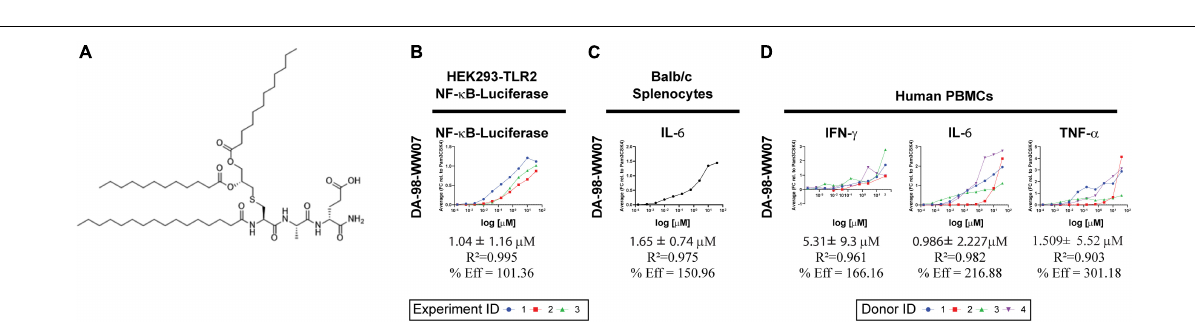
FIGURE 3 | Activity of a novel TLR1/2 agonist, DA-98-WW07. (A) Structure of DA-98-WW07 (IUPAC Name) (4 R ,7 S ,10 R ,14 R )-4-carbamoyl-14-(dodecanoyloxy)- 7-methyl-6,9,17-trioxo-10-palmitamido-16-oxa-12-thia-5,8-diazaoctacosanoic acid). (B) Luciferase expression in HEK293-cells stable transfected with FLAG-tagged human TLR2 and a NF- κ B-luciferase reporter gene after stimulation with various doses of DA-98-WW07. Pam 3 CSK 4 was used as a benchmark for the calculation of percent efficacy. The curves represent three independent experiments. The top curve was generated from only one data set, while the bottom curves were the best fit from two replicate data sets. (C) Murine splenocytes were stimulated with different concentration of DA-98-WW07. Secretion of IL-6 in the supernatants was measured as an indicator of DA-98-WW07 activity. The best fit curve from a single experiment is shown panel (D) Human PBMCs were stimulated with different concentrations of DA-98-WW07. Secretion of IFN- γ , TNF- α and IL-6 in the supernatants was measured as an indicator of DA-98-WW07 activity. The curves represent different